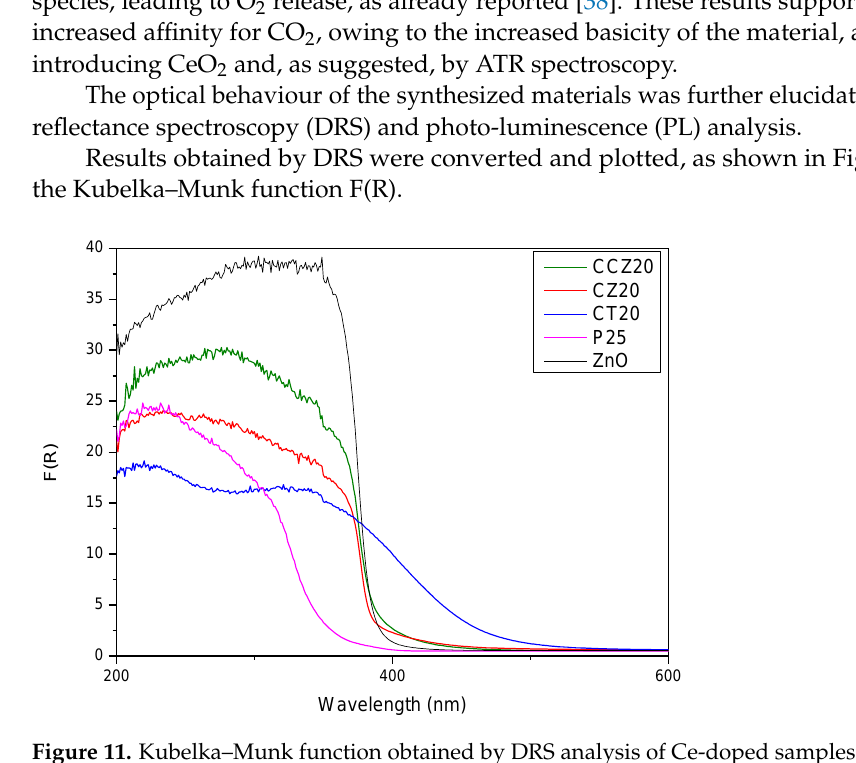
Table 2. Calculated band gap values and Urbach energies obtained via Tauc plot and Urbach plot methods,